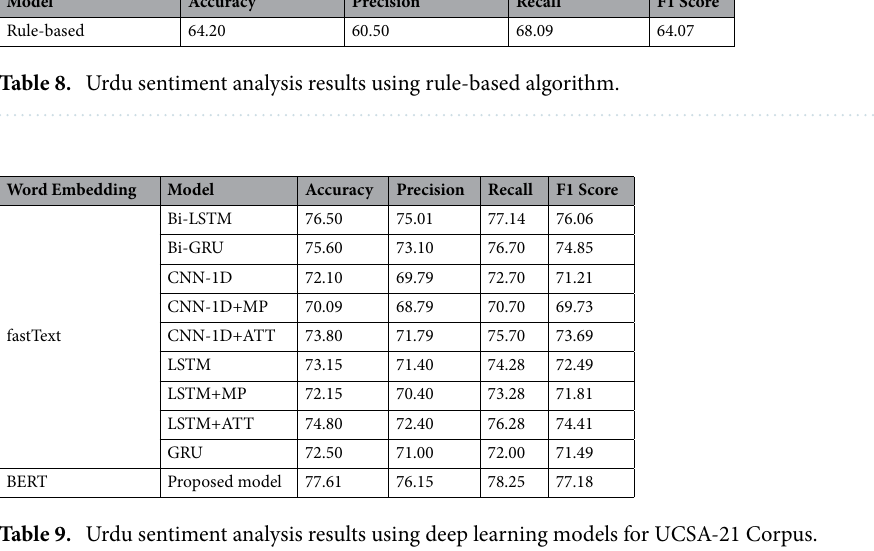
Table 9. Urdu sentiment analysis results using deep learning models for UCSA-21